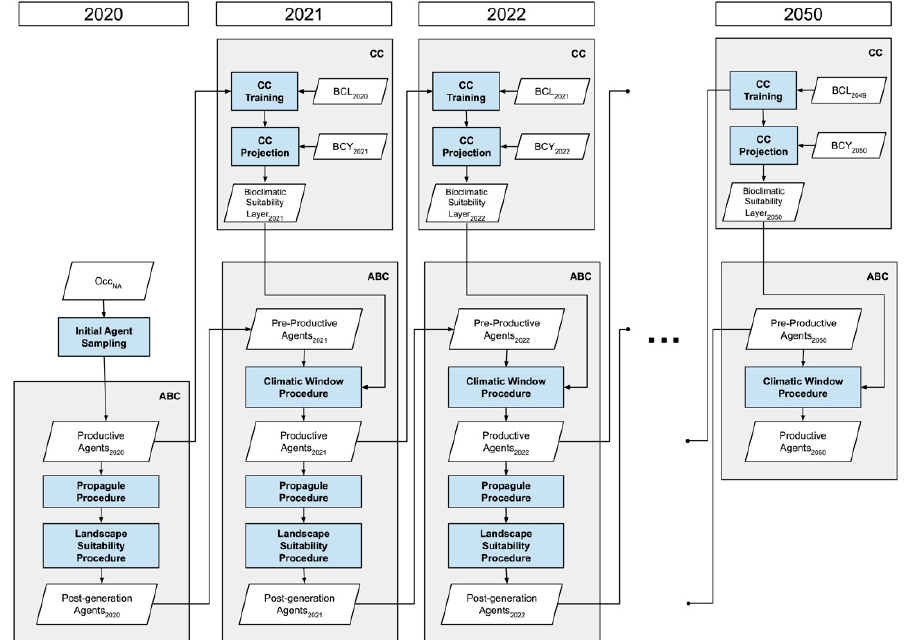
Figure 2. Workflow of the framework throughout the simulation period 2020–2050. (ABC: Agent- Based Component; CC: Correlative Component; Occ NA : Initial Occurrence Records in North America; BCL: long term bioclimatic variables; BCT: Yearly bioclimatic variables).